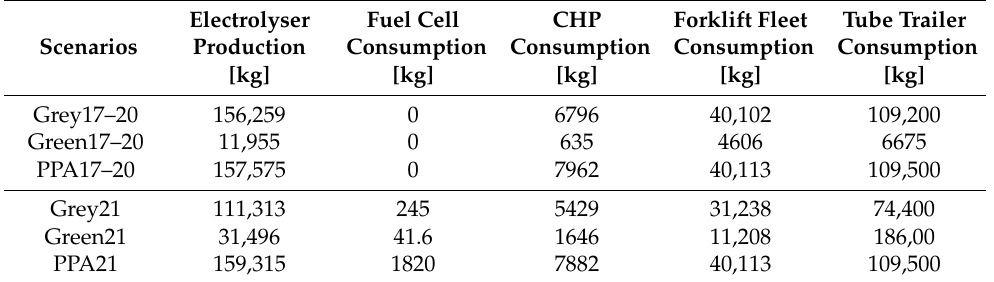
Table 9. Average yearly H 2 production and consumption, for a 13-year